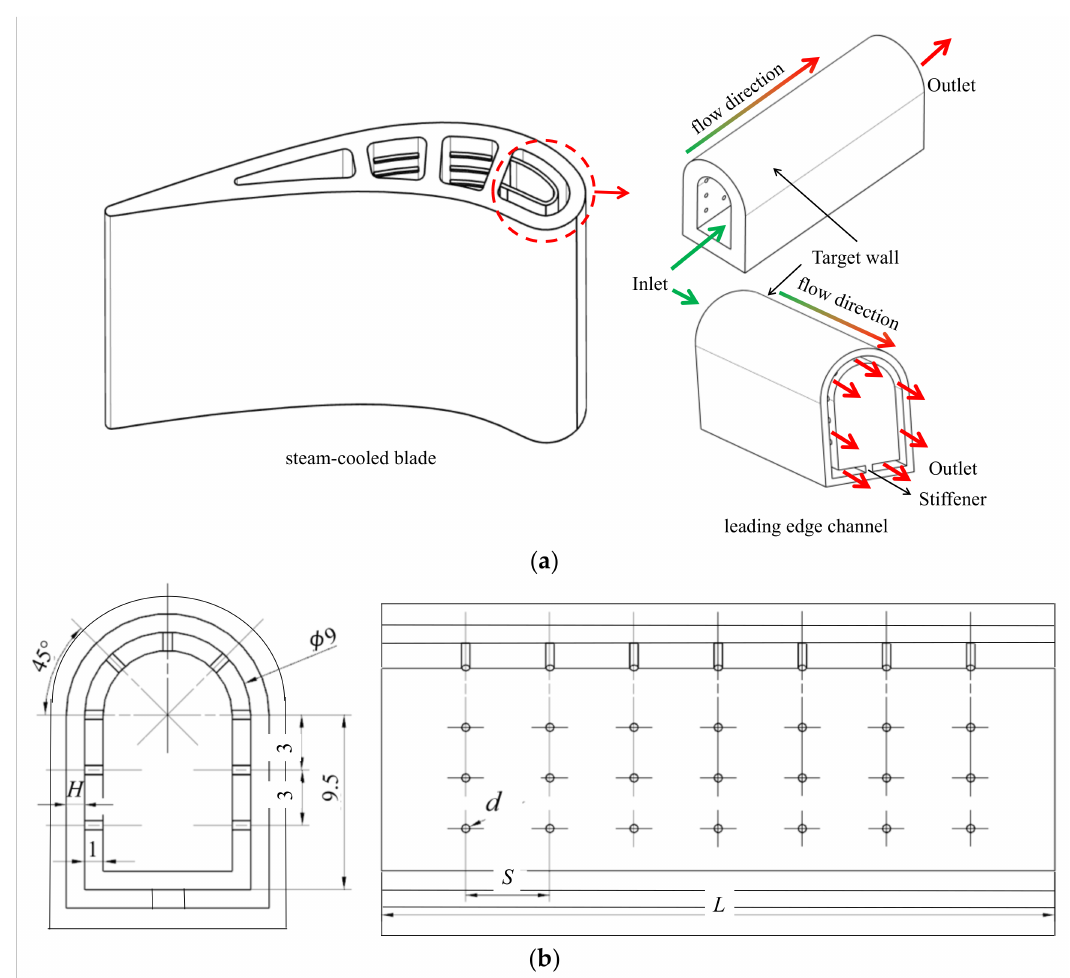
Figure 1. Research object: ( a ) the steam-cooled gas turbine blade; ( b ) the simplified leading edge